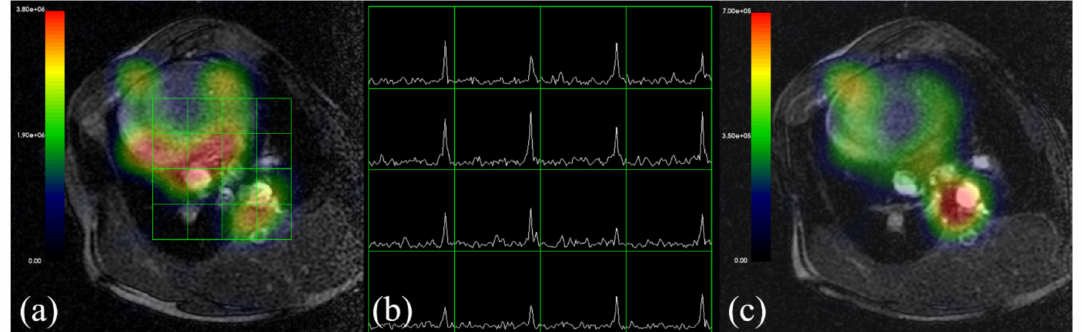
Figure 8. Three-dimensional 13 C MRSI results in the swine cardiac. ( a ) Signal map of [1- 13 C] pyruvate with 4 × 4 13 C spectral grid; ( b ) corresponding 13 C spectra of [1- 13 C] pyruvate at 4 × 4 13 C spectral grid in ( a ); ( c ) signal map of [1- 13 C] lactate over heart and blood vessels. Color bar numbers are